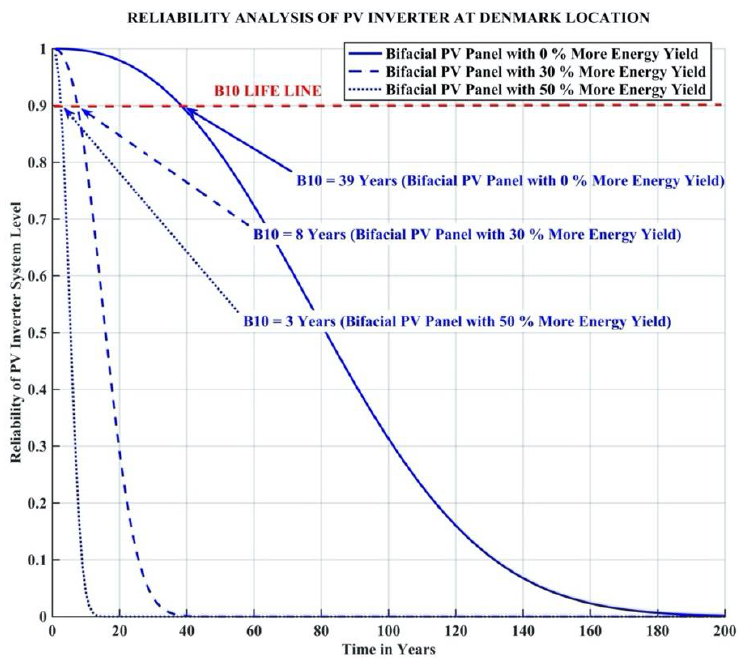
Figure 24. Reliability function of the PV inverter at the location in Denmark (System Level). B10 lifetimes considering bifacial PV panels at both the India and Denmark locations are tabulated in Table 6. Table 6. B10 lifetimes of PV inverters considering bifacial PV panels. Bifacial PV Panel % Additional Country